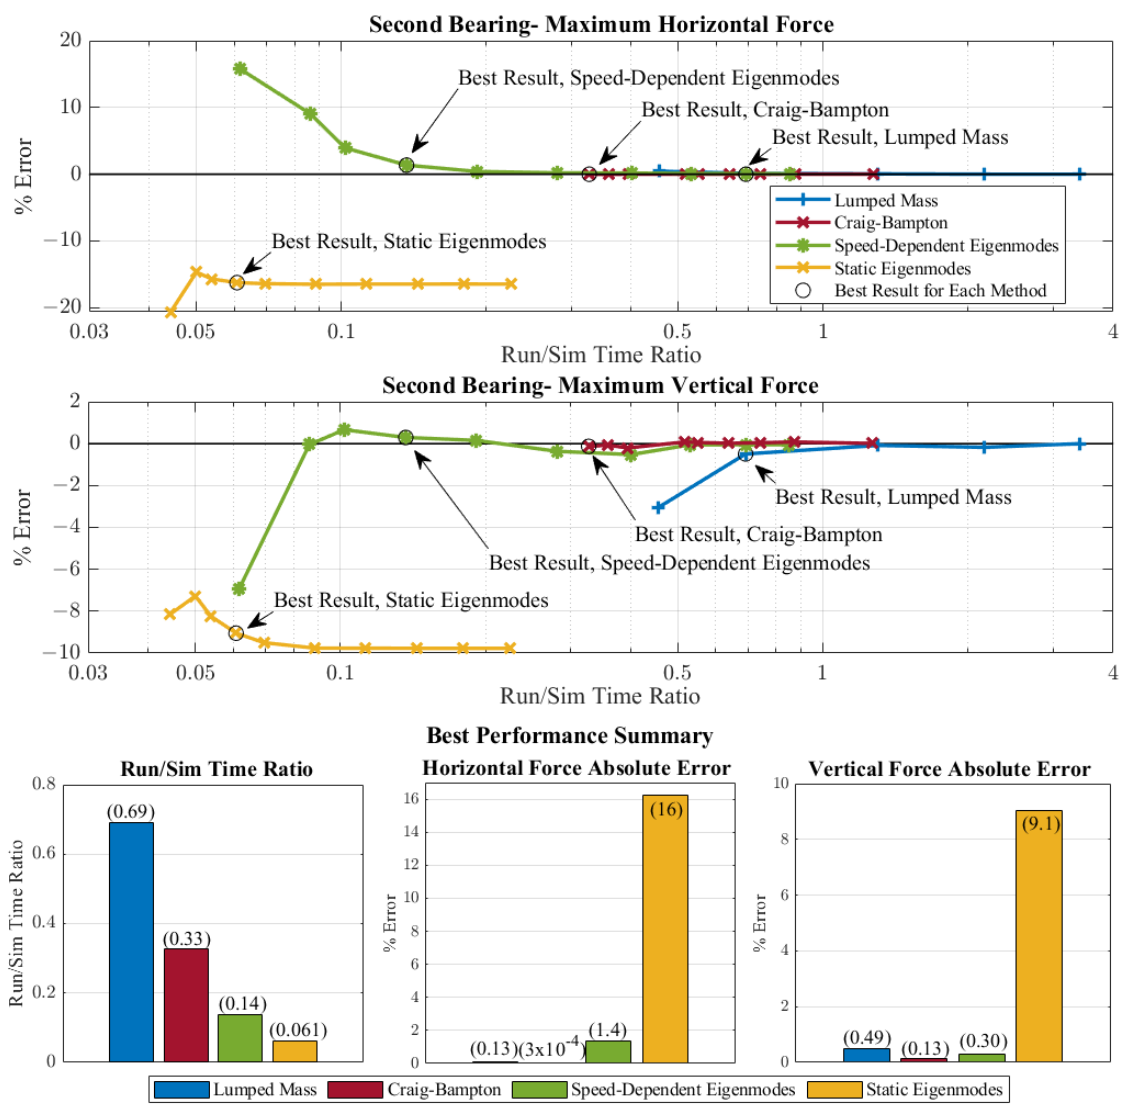
Figure 8. Comparison of the % error and run/sim time ratios of the different simulation modeling methods. For the % error, the reference results are the forces computed by the lumped mass model simulation with 200 DOFs (50 nodes). The reference results are 2858 N for the horizontal bearing force and 3175 N for the vertical bearing. For the run/sim time ratio, the simulated time is 100 s. For each curve, the markers represent different DOFs: 4 × (number of lumped elements) or number of modes. The circles indicate the most computationally efficient simulation that converges within 2% of the reference result. Increasing the number of DOFs generally increases the simulation accuracy (as shown by curves converging to an error of 0) while increasing the run time.